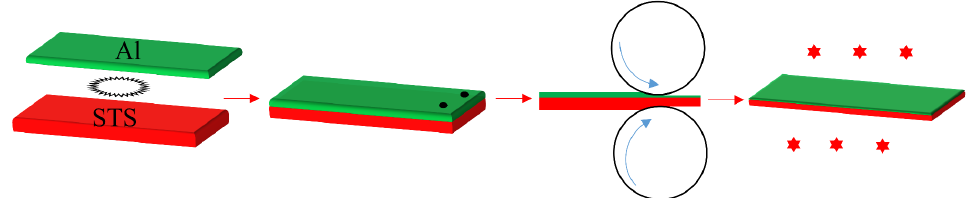
Figure 1. Diagrammatic drawing of the manufacturing and preparation process for AlZn4SiPb/steel clad composites.